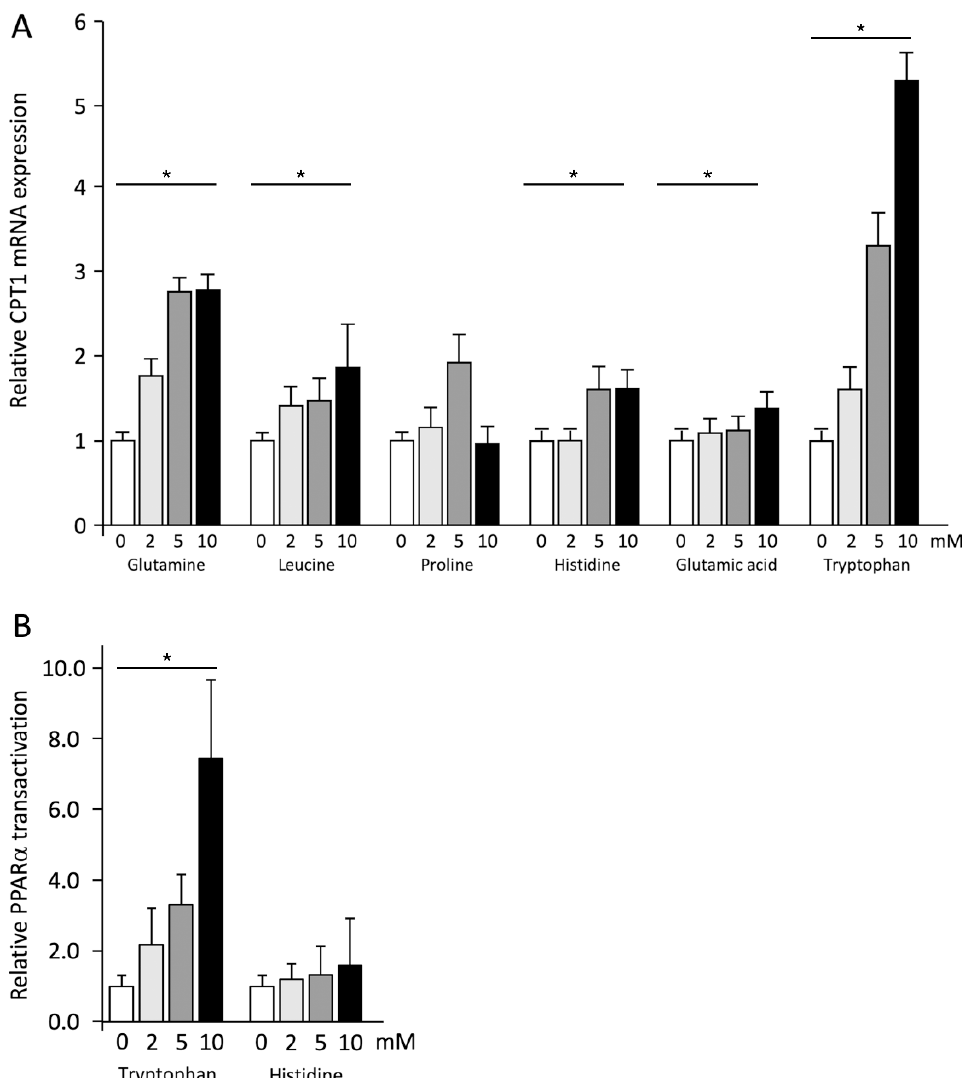
Figure 4. Amino acids have different effects on CPT1 mRNA expression and PPAR α transactivation. ( A ) CPT1 mRNA expression in HepG2 cells treated for 48 h with 0–10 mM of six amino acids, measured by qPCR. ( B ) PPAR α transactivation in HepG2 cells that were co-transfected with a pcDNA3.1 and pGL3_PPRE vector; 24 h after transfection, cells were treated with 0–10 mM of tryptophan or histidine in medium supplemented with 10% FBS for 48 h, after which cells were